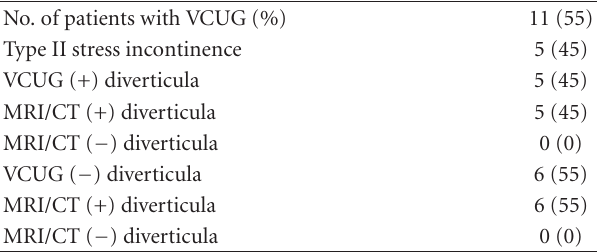
Table 4: VCUG in patients with symptoms of